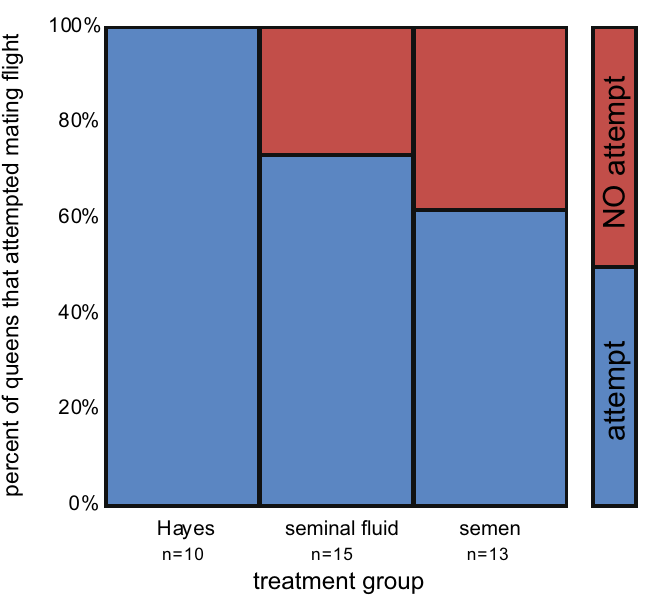
Figure 2. Queen Mating Flight Attempts (sexual receptivity). There was a significant difference in the percentage of queens from the different treatments attempting mating flights (chi-square (Pearson) = 10.526, df = 1, p < 0.005; Fig. 2). While 100% of HS queens attempted mating flights during the observation period, only 62% of SF queens and 73% of SE queens attempted mating flights. Blue represents queens that attempted a mating flight and red represents queens that did not attempt a mating